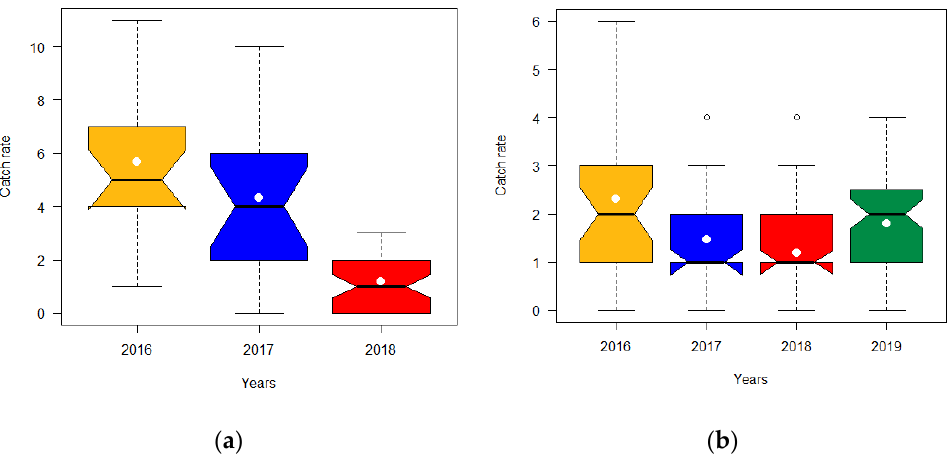
Figure 4. Mean catch rate (white dot), i.e., number of decapods caught in a 24 h deployment period, with 25 and 75% quartiles (lower and upper box margin, respectively) and 95% confidence interval (whisker), median (thick black bar), notch (95% confidence interval of the median), and possible outliers (open dots) among the different survey years for ( a ) small and ( b ) large cages.